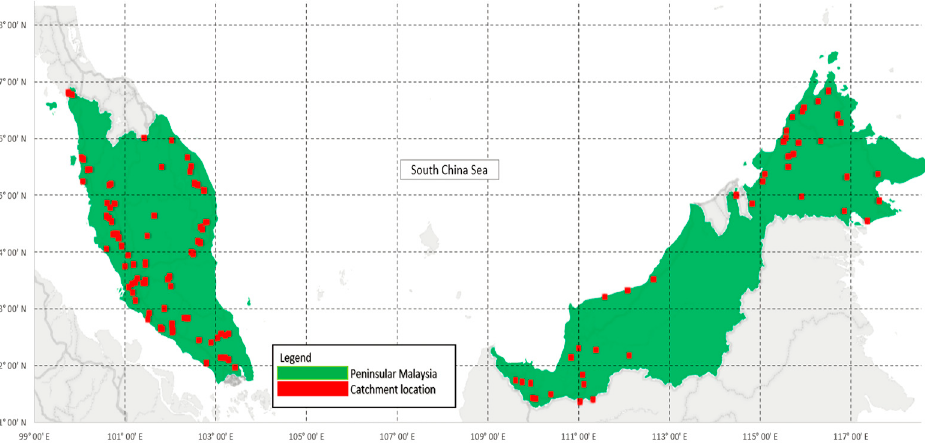
Figure 2. Location where the rainfall runoff datasets were collected for Peninsular Malaysia and East Malaysia [36,37].